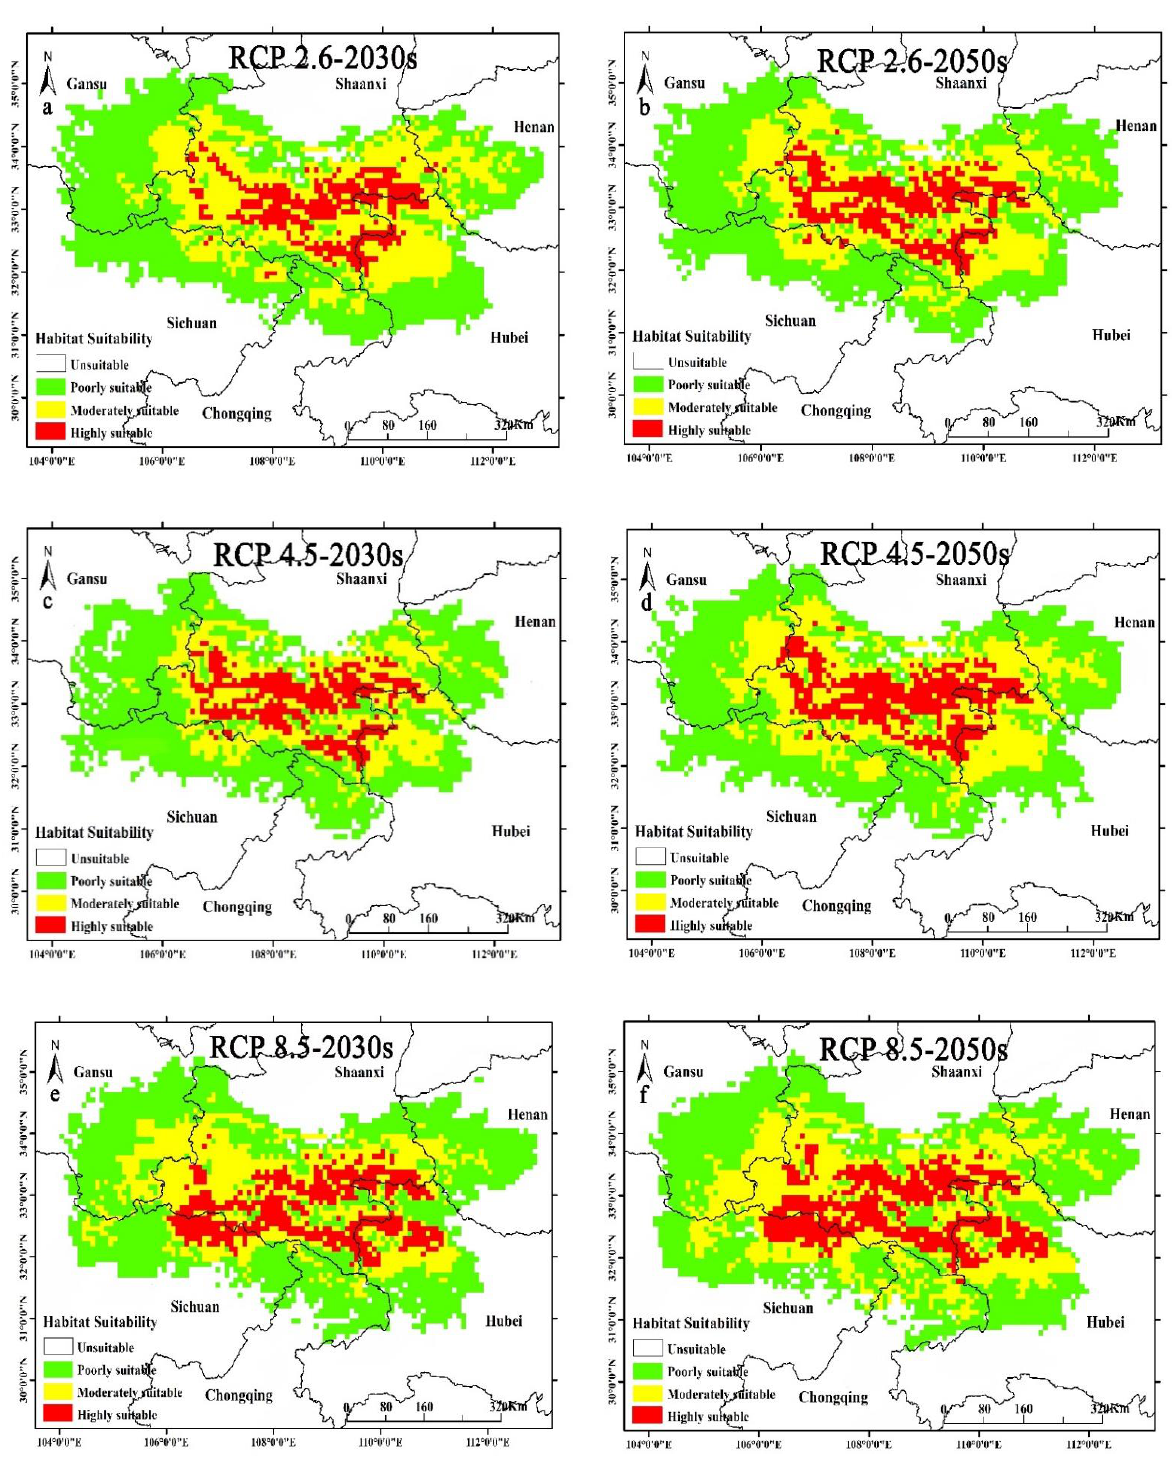
Figure 4. Future distribution of suitable habitat for Dendroctonus armandi in China. The 2030s represents 2021–2040, and 2050s represents 2041–2060. (( a , b ), future distribution of suitable habitat under RCP2.6 in 2030s and 2050s, respectively; ( c , d ), future distribution of suitable habitat under RCP4.5 in 2030s and 2050s, respectively; ( e , f ), future distribution of suitable habitat under RCP8.5 in 2030s and 2050s,